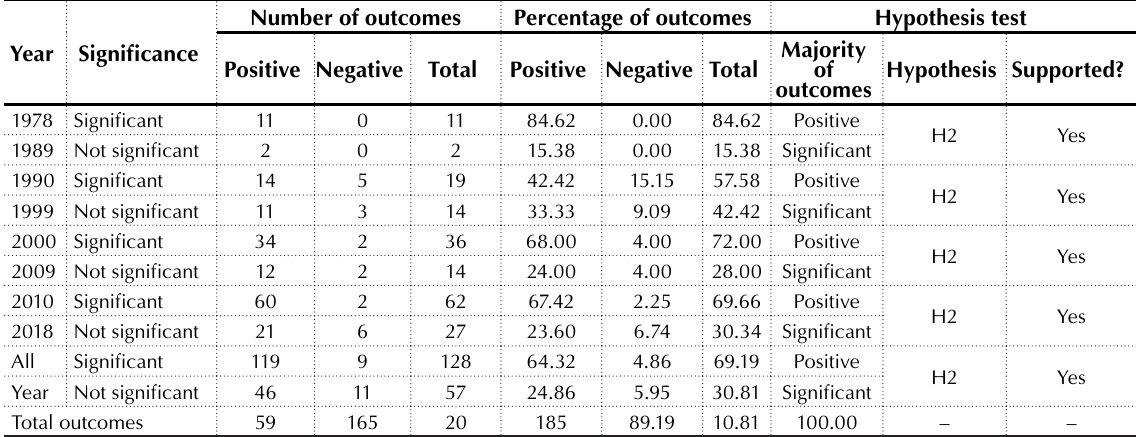
Table 4. Results – vote-counting method – penalty